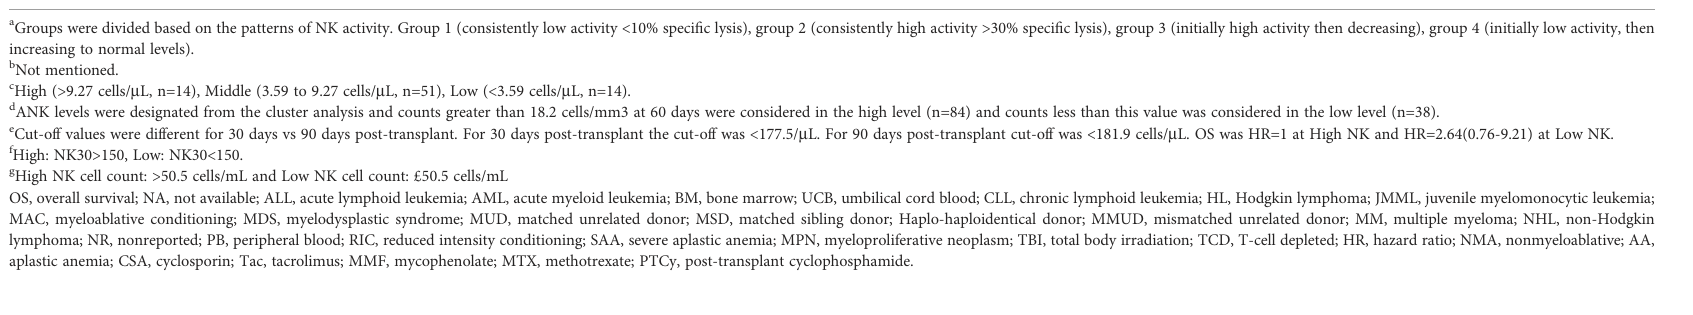
High: 21 MSD/MUD High: 81 Low:35 39 (53) Low:50 at2 Y Haplo 28 (40) at2 Y